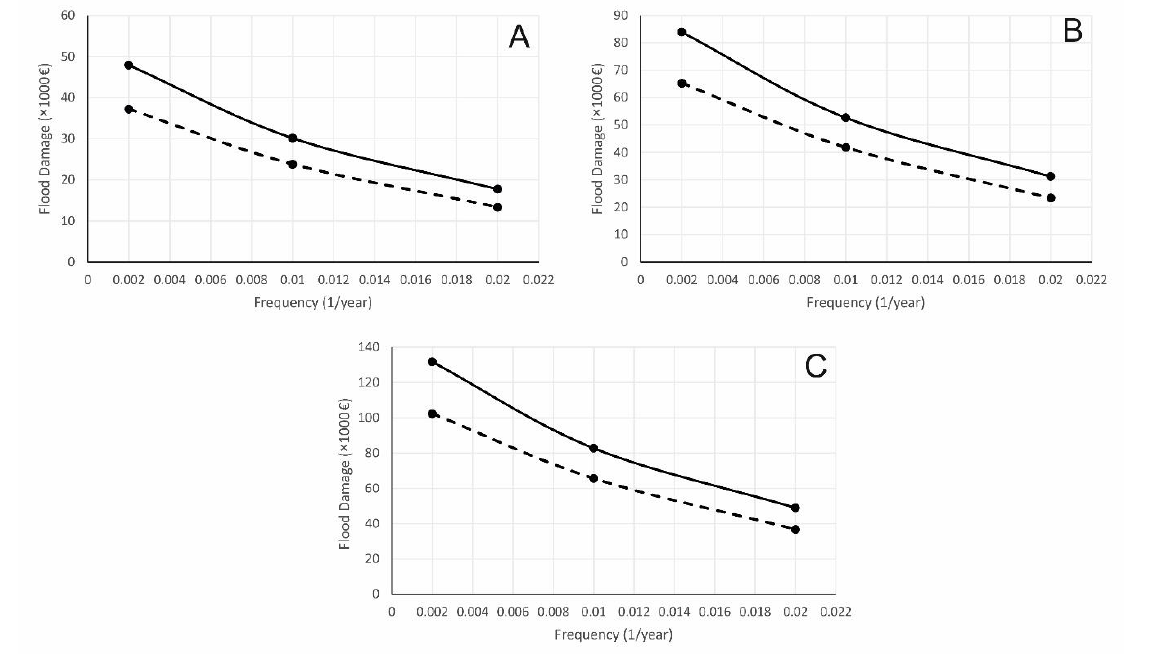
Figure 8. Damage–frequency curves for Navaluenga town considering content ( A ), structure ( B ) or content + structure ( C ). The solid line represents the original results, and the dashed line represents the results linked to the consideration of the topographic di ff erence between the main floor of housing and the surrounding land.